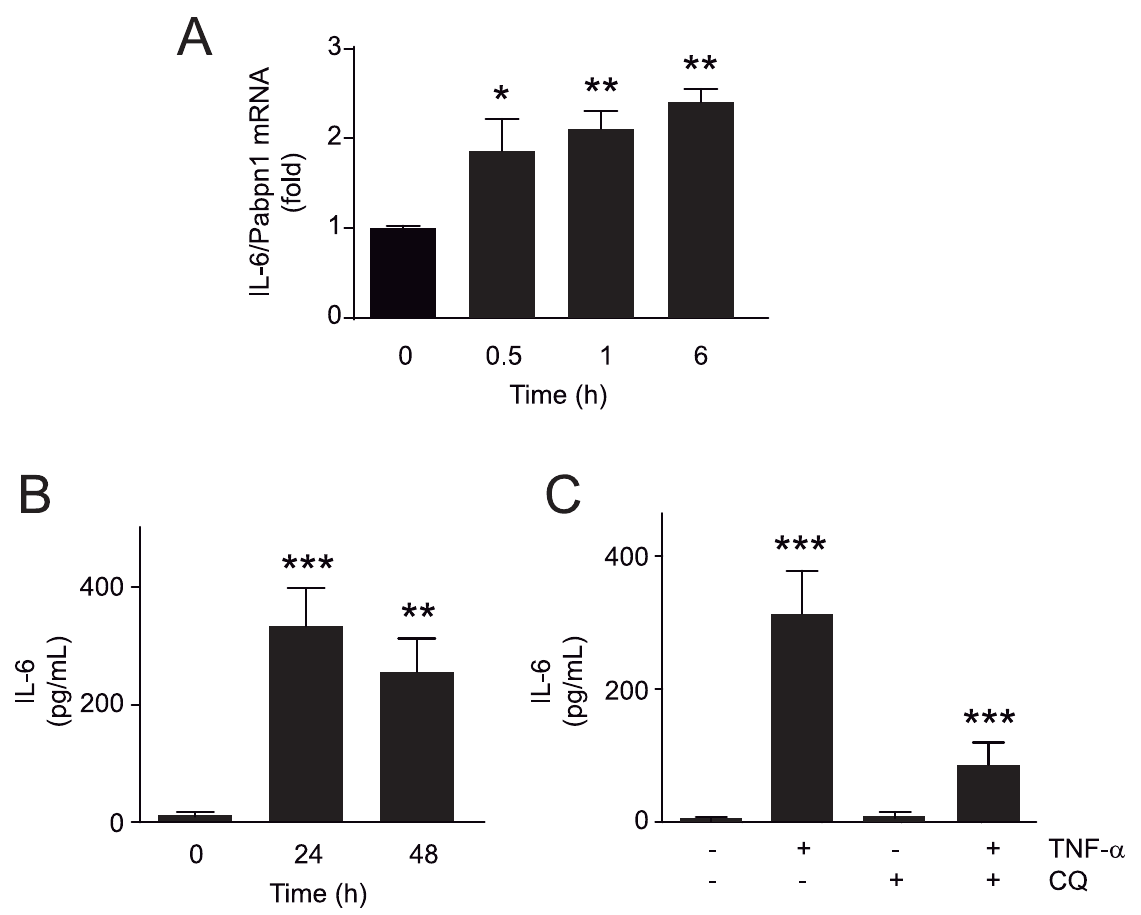
Fig 5. Autophagy mediates TNF- α -induced secretion of IL-6 in A7r5 cells. ( A ) Determination of IL-6 mRNA using RT-qPCR in A7r5 cells treated with TNF- α (100 ng/mL) for 30 min, 1 and 6 h (n = 6; (cid:3) p < 0.05, (cid:3)(cid:3) p < 0.01 vs 0 h). ( B ) Determination of IL-6 using ELISA assay in A7r5 cells treated with TNF- α (100 ng/mL) for 24 and 48 h (n = 4; (cid:3)(cid:3) p < 0.01, (cid:3)(cid:3)(cid:3) p < 0.001 vs 0 h) or ( C ) co-administered with or without chloroquine (CQ, 20 μ mol/L) during the last 4 h of the 24 h stimulus with TNF- α (n = 4; (cid:3)(cid:3)(cid:3) p < 0.001 vs control). Data are expressed as mean ± SEM and analyzed by one-way ANOVA, followed by Dunnett and Tukey